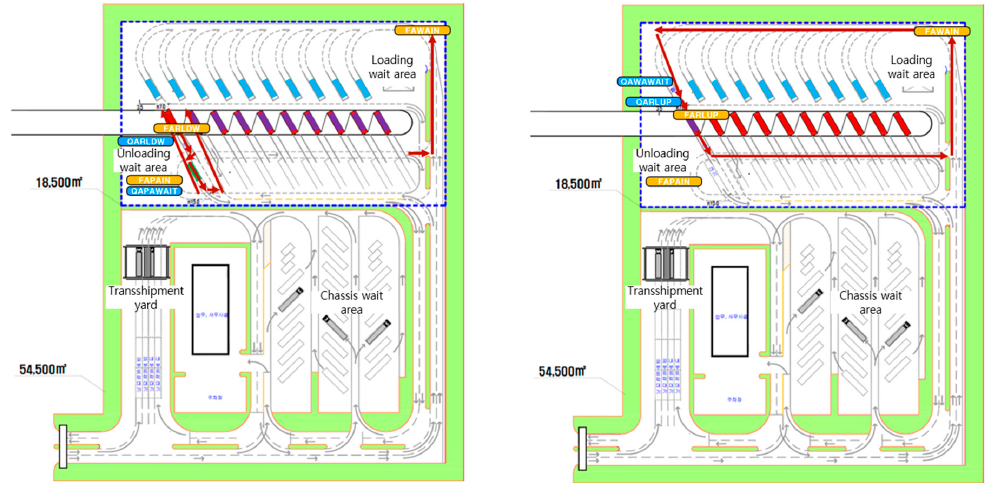
Figure 7. Operation logic for loading or unloading tractors (left: unloading; right: loading).